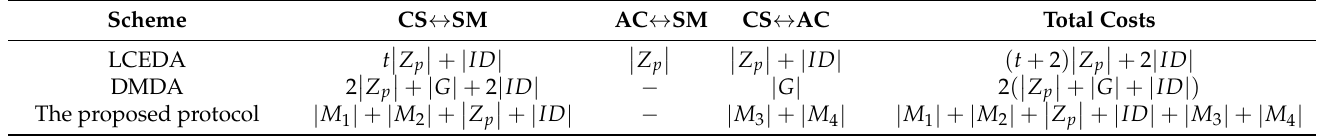
Table 4. Comparisons of communication costs in the enrollment stage.